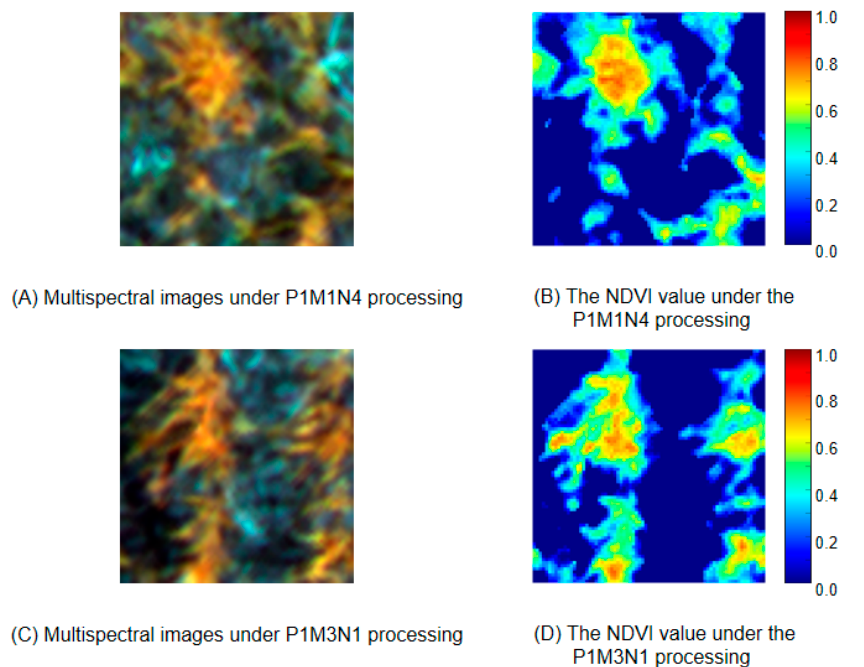
Figure 5. NDVI values for winter wheat variety 1 (P1) in ( B ) high-nitrogen fertilizer and low-density treatment ( A , D ) low-nitrogen fertilizer and high-density treatment ( C ).